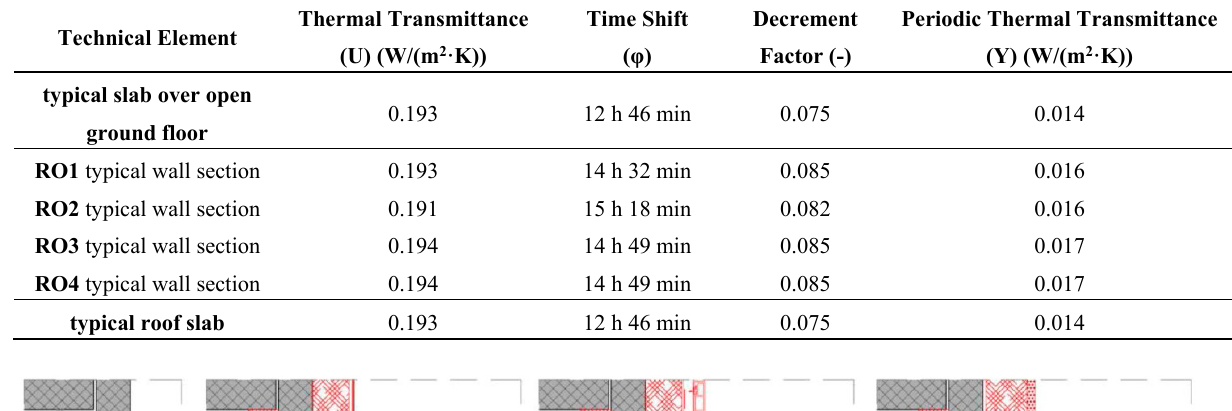
Table 3. Thermal characteristics of main elements after renovation.